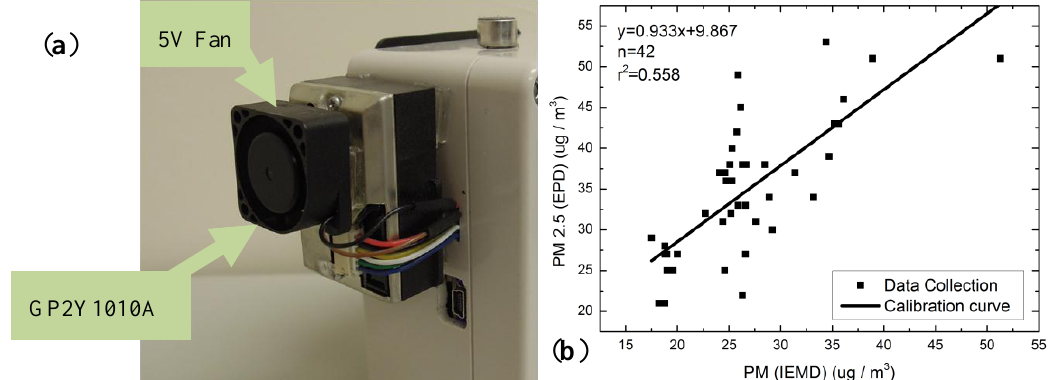
Figure 7. ( a ) PM 2.5 sensor; ( b ) calibration curve for PM 2.5 sensor; ( c ) comparison between EPD data with non-calibrated and calibrated IEMD